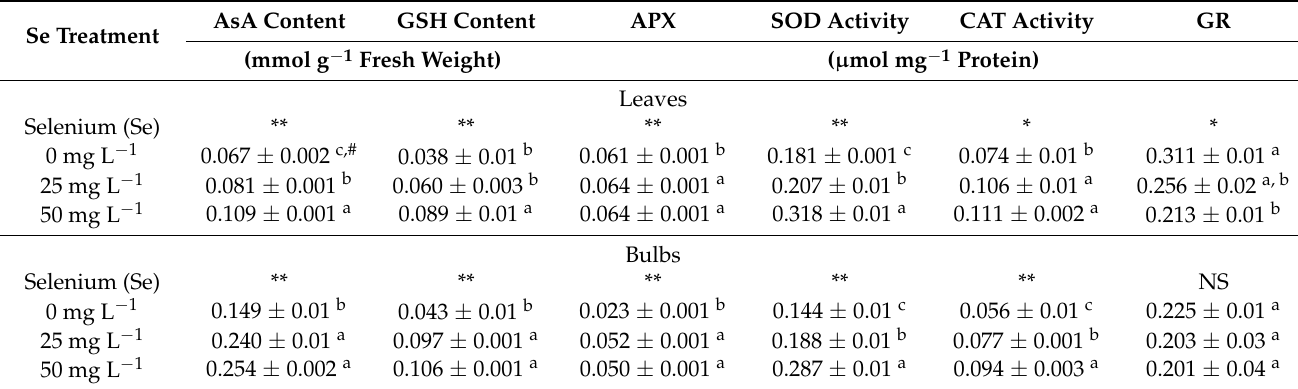
# Values are means of ( n = 5). Mean values in each column followed by a different lower case letter are significantly different by Student Newman–Keuls test at p ≤ 0.05. ** and * indicate respective differences at p ≤ 0.05 and p ≤ 0.01 probability level, and “NS” indicates not significant difference.